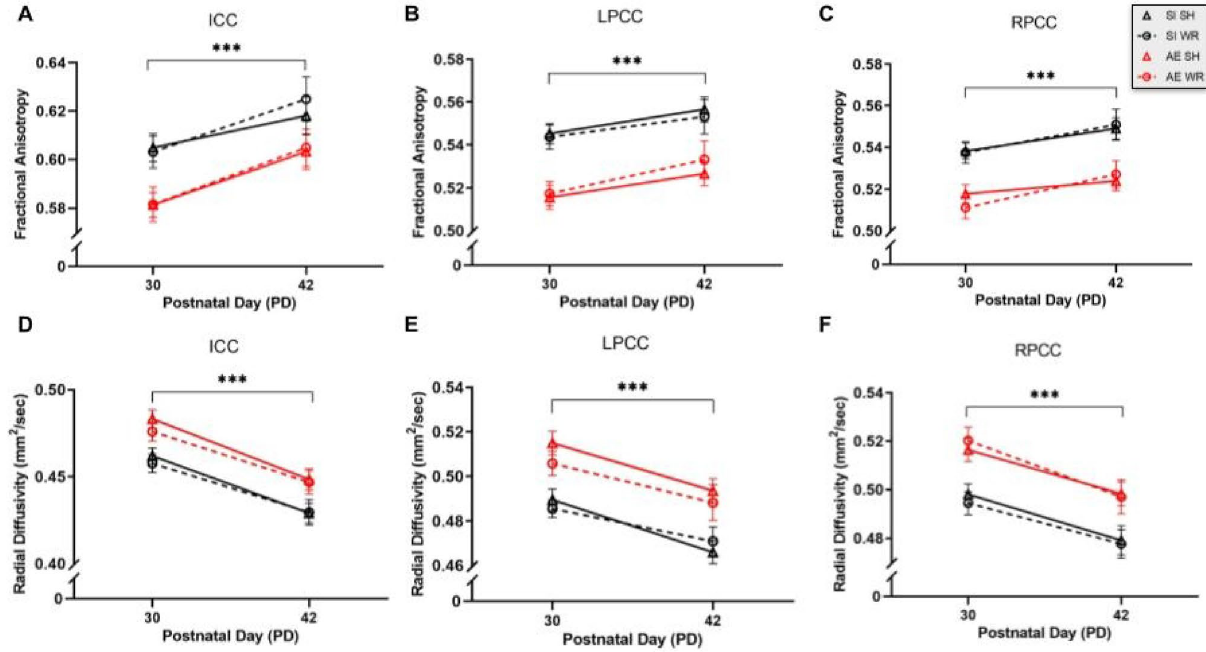
Figure 7. Average within-animal ICC, LPCC, and RPCC fractional anisotropy ( A – C , respectively) and radial diffusivity ( D – F , respectively) in AE/SH, AE/WR, SI/SH, and SI/WR rats during the intervention period. Mixed repeated measures ANOVA indicates that age-related alterations to fractional anisotropy and radial diffusivity are inversely proportional in all CC sub-regions (*** p < .001). All data are shown collapsed across sex as the analyses indicate no main or interactive effects of sex on the DTI measures. n = 7–12 per sex/postnatal treatment/intervention group. Error bars are mean ±